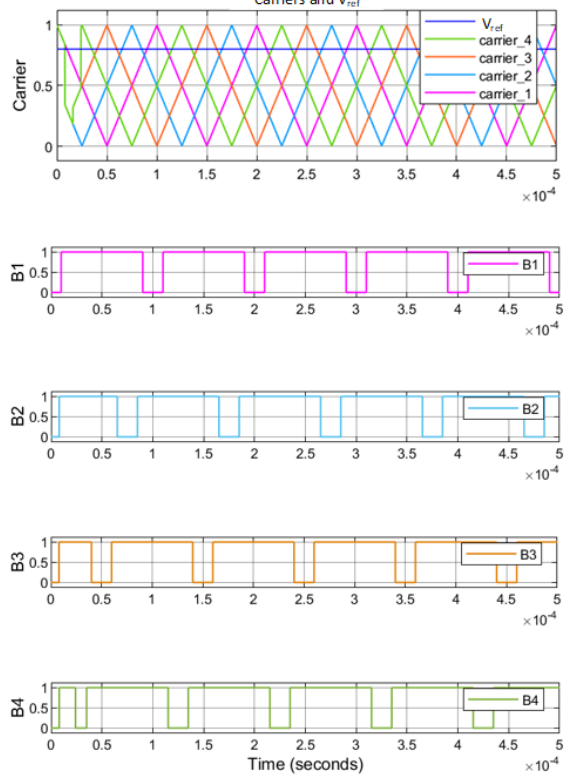
Figure 13. PWM signals on the gates of the high-side switches (B 1 …B 4 ) of the converter cells.